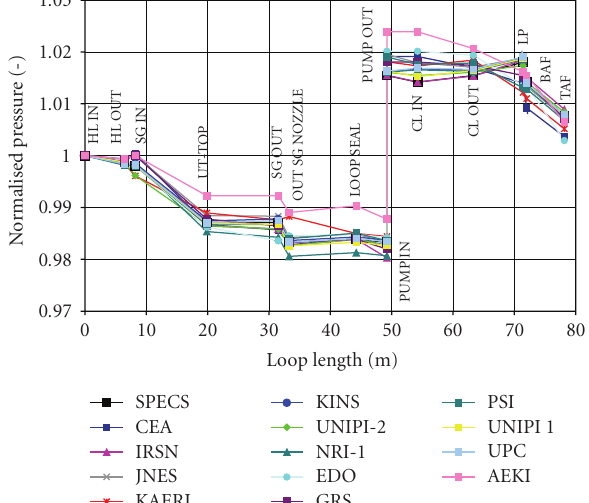
Figure 4: Normalized pressure curve along the loop.